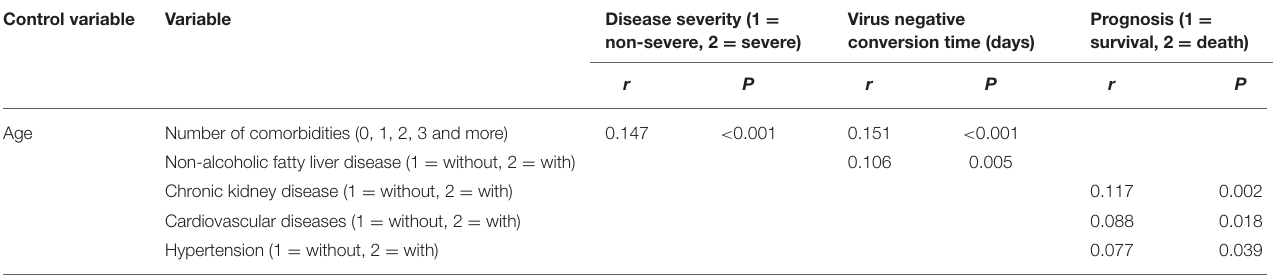
TABLE 6 | Partial correlation analysis of disease severity, virus negative conversion time, prognosis and comorbidities (when controlling for age) ( n = 718). Control variable